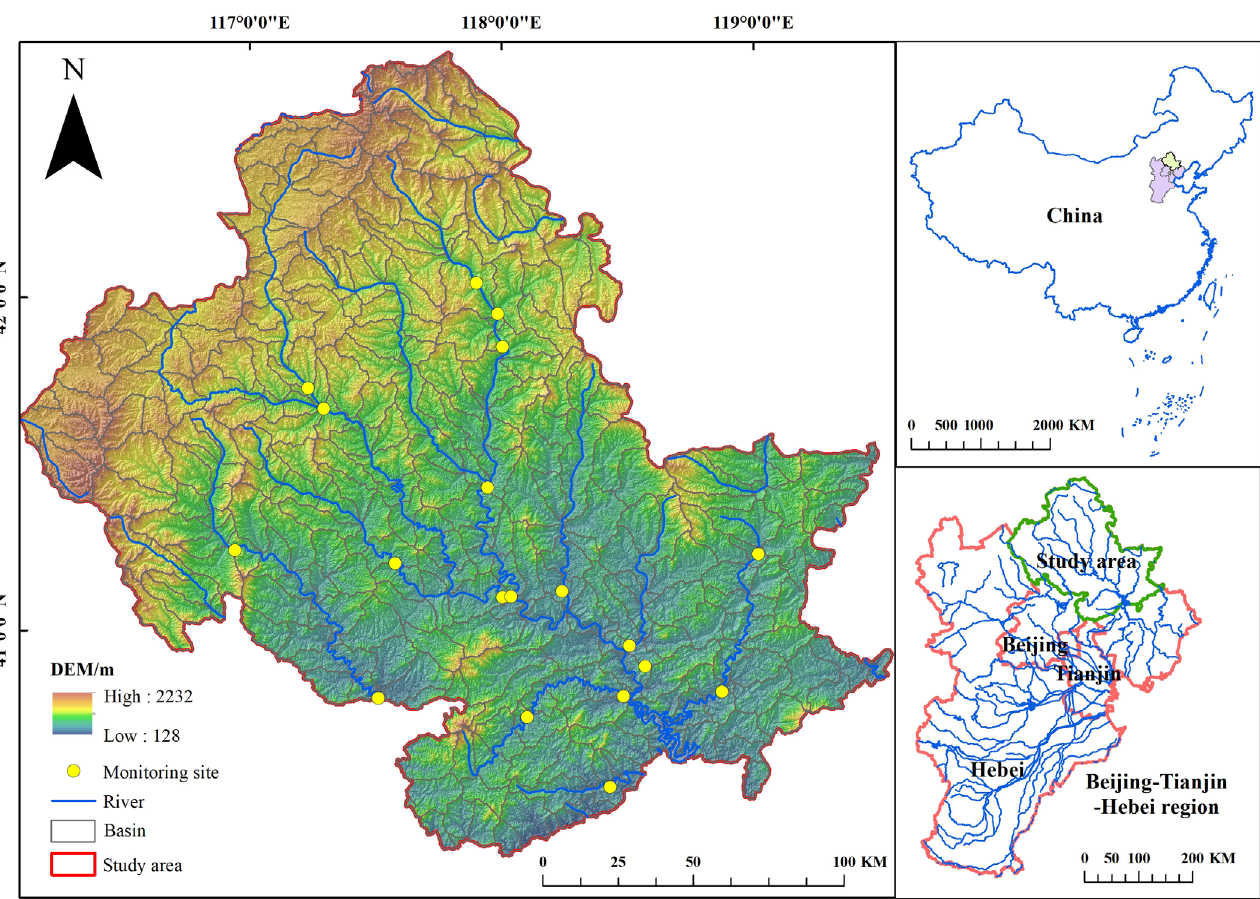
Figure 1. Study Figure 1. Study area.